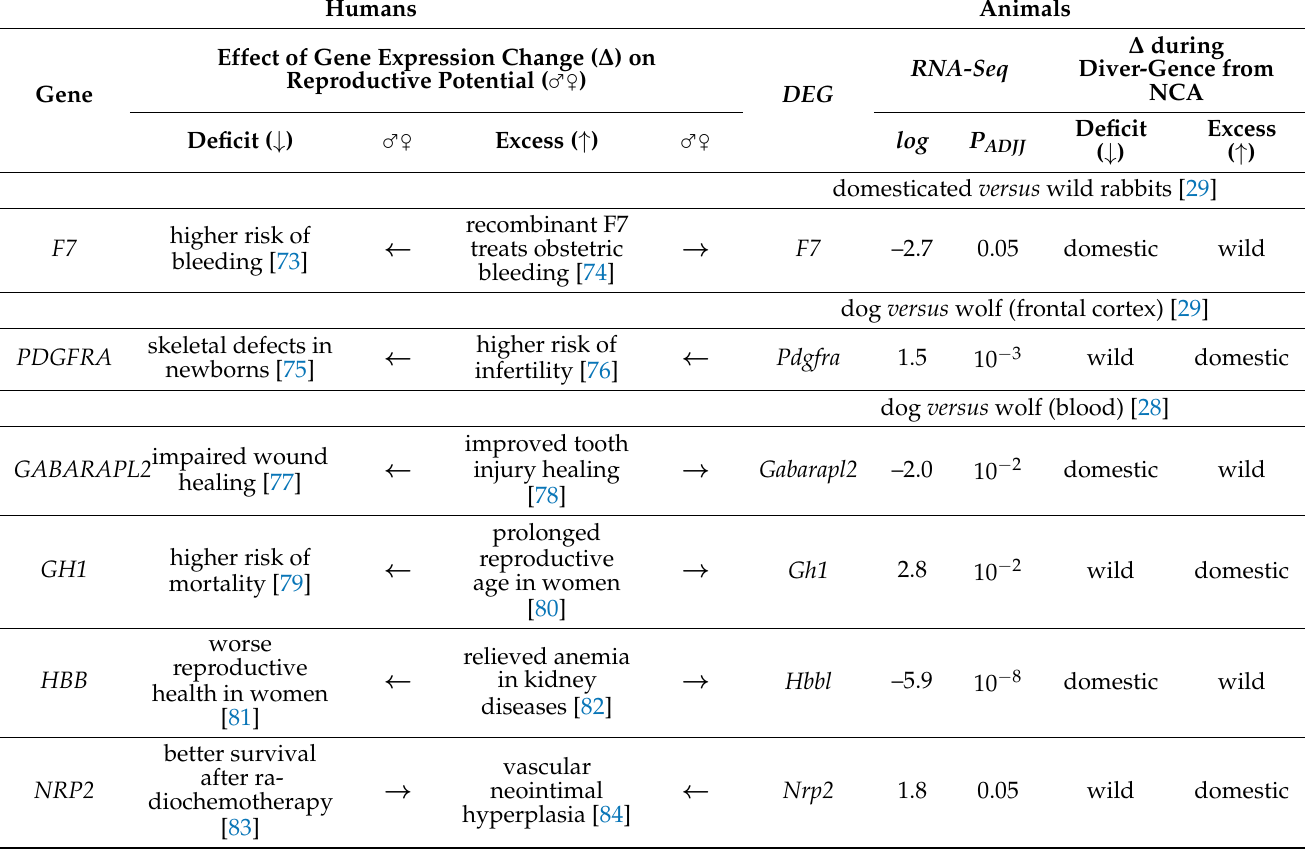
Table 4. Comparing the effects of changes in the expression of orthologous genes on human reproductive potential and on the divergence of domestic and wild animals from their nearest common ancestor (NCA). Humans Animals